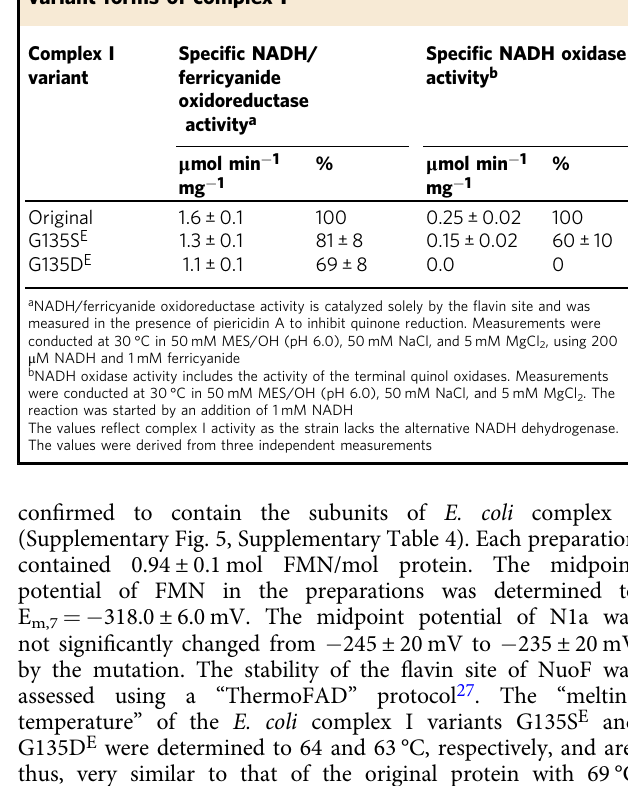
Fig. 5 The crystal structure of the NADH-binding site of NuoEF S96M F in the reduced ( a ) and oxidized ( b ) state. Electron densities are given as 2F o – F c maps contoured at 1.0 σ . a One protomer in the asymmetric unit fl ips the peptide carbonyl of Glu95 F to Arg135 F . b In the second protomer, the carbonyl predominantly points toward FMN. The according backbone position of the fi rst protomer shown in ( a ) is given as reference (cyan), demonstrating that this conformation does not fi t well into the electron density. The crystal structure of the oxidized A. aeolicus NuoEF variant S96M that mimics the E. coli architecture of the binding pocket shows that here the peptide bond adopts both previously observed positions in each protomer of the asymmetric unit: One corresponds to the position in the oxidized NuoEF, the other to that in the reduced enzyme, although the electron density is not clearly enough de fi ned to assign full occupancies for either conformer due to the relatively low resolution of 3.22 Å (PDB ID 6R7P). Intriguingly, the limited quality of the electron density map unequivocally allows for observing differences between the protomers in preferring a conformer: The fi rst protomer predominantly fl ips the carbonyl toward Arg135 F ( a ), the other one shows a higher occupancy for the carbonyl fl ipped toward the FMN ( b ). Thus, the E. coli complex I is capable of fl Table 1 Catalytic activity of E. coli membranes containing variant forms of complex